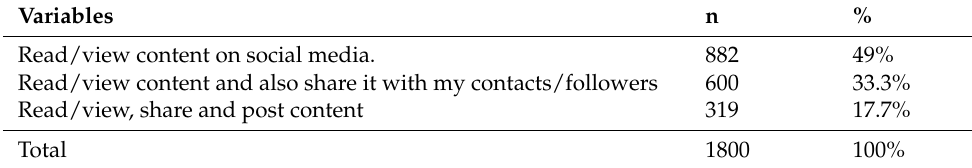
Table 7. Most frequent activities on social